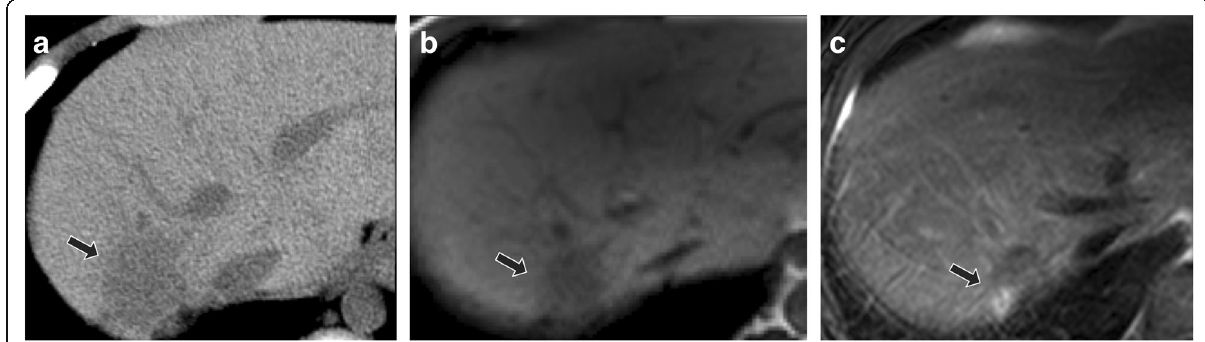
Fig. 3 Focal Gaucher cell accumulation in the liver. Axial non-contrast abdominal CT ( a ) demonstrates a focal hypoattenuating hepatic lesion (arrow) in the posterior right hepatic lobe in 10-year-old male with type 1 Gaucher disease. At follow-up at 16 years of age with unenhanced MRI, lesion (arrow) was unchanged in size with T1-weighted hypointense ( b ) and mixed T2-weighted signal intensity ( c ). Findings are most consistent with focal Gaucher cell deposition ( “ Gaucheroma ”